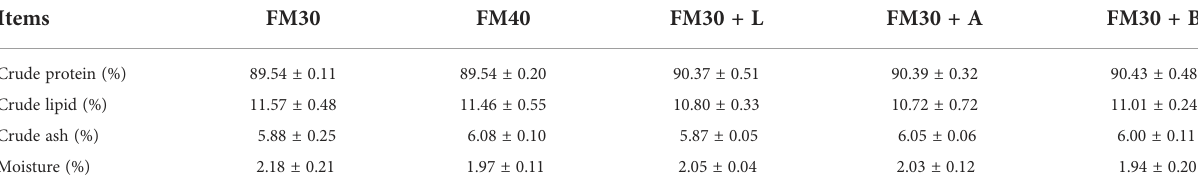
TABLE 5 Effects of limonene, allicin and betaine on muscle composition (dry-weight basis) of M. salmoides for 9 weeks. Items